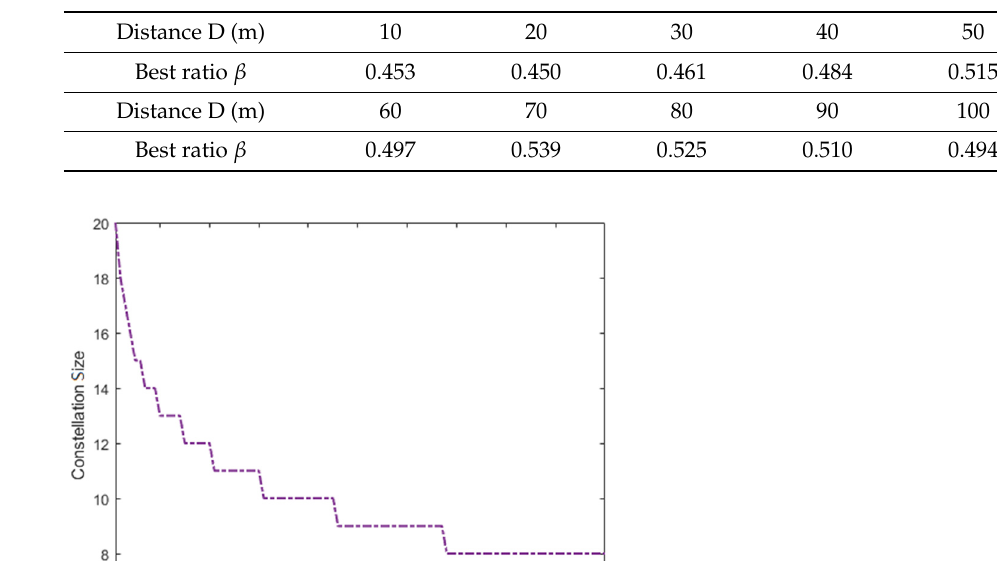
Table 2. Constellation sizes at different distances.